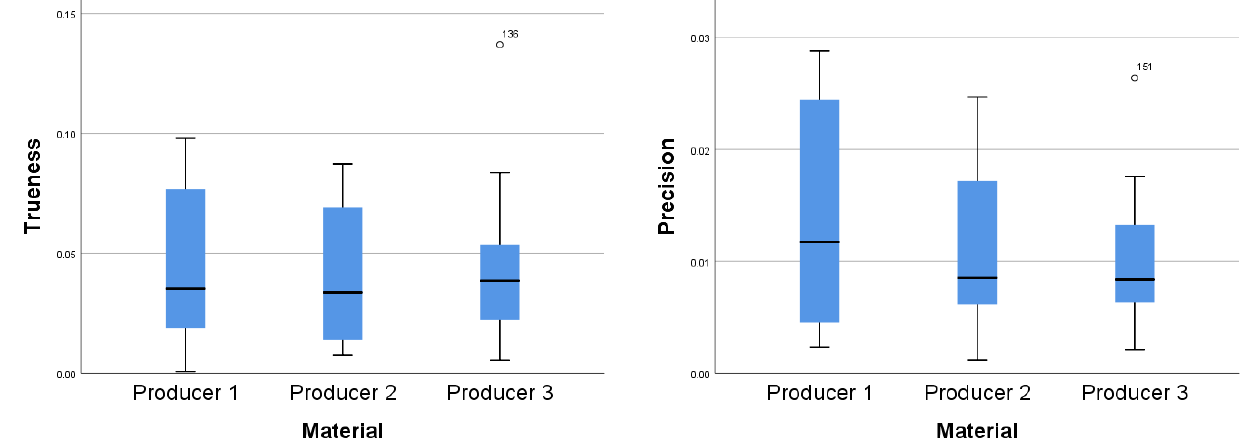
Figure 9. Distributions of precision values ( left ) and trueness values ( right ) for tooth height between the three material groups.